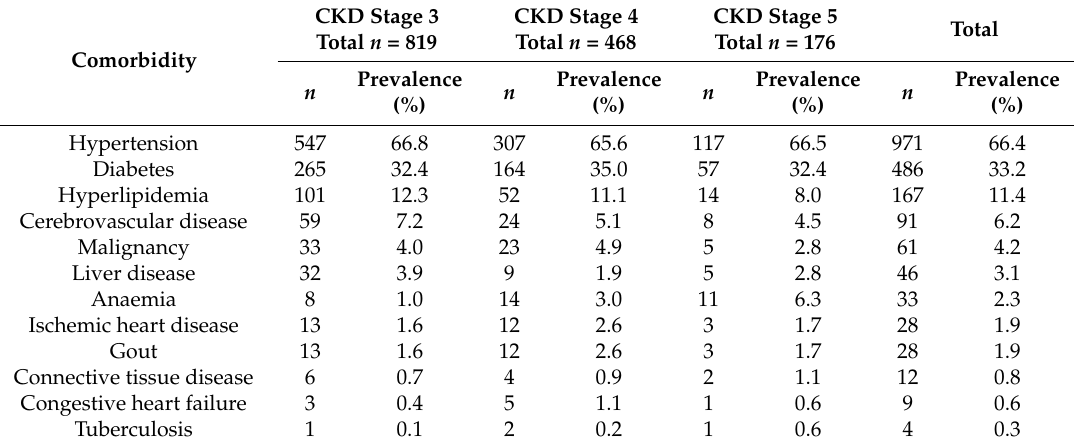
Table 2. Prevalence of individual comorbidities at